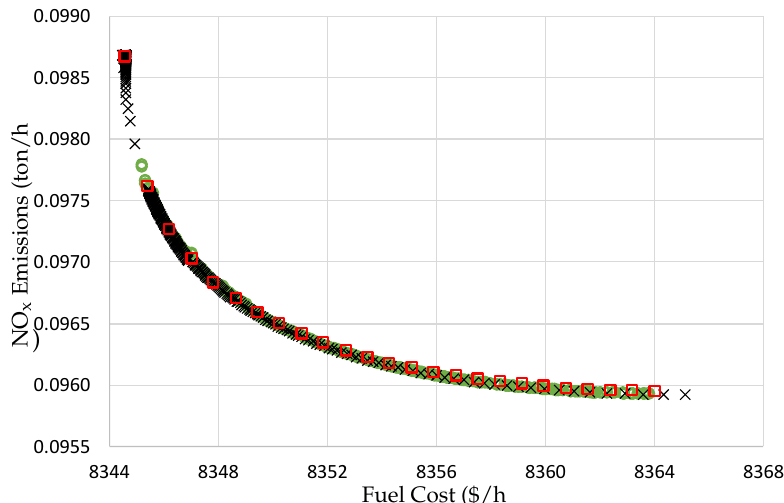
Figure 8. Pareto front for fuel cost and NO x emissions constructed using 500 elements. Red squares represent SQP, green circles represent NSGA-II , and black × represent NPHC.